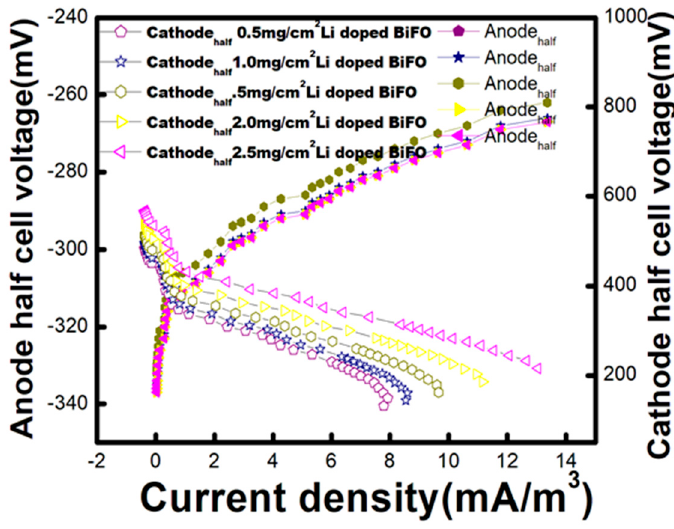
Figure 11. Polarization data for anode and cathode half-cell. The anode and cathode half-cell data points are presented as solid and open symbols. A fixed quantity of graphene (0.3 gm/cm 2 ) was loaded to different conc of BiFe 1 − x Li x O 3 support for the comparison (0.5–2.5 mg/cm 2 ).